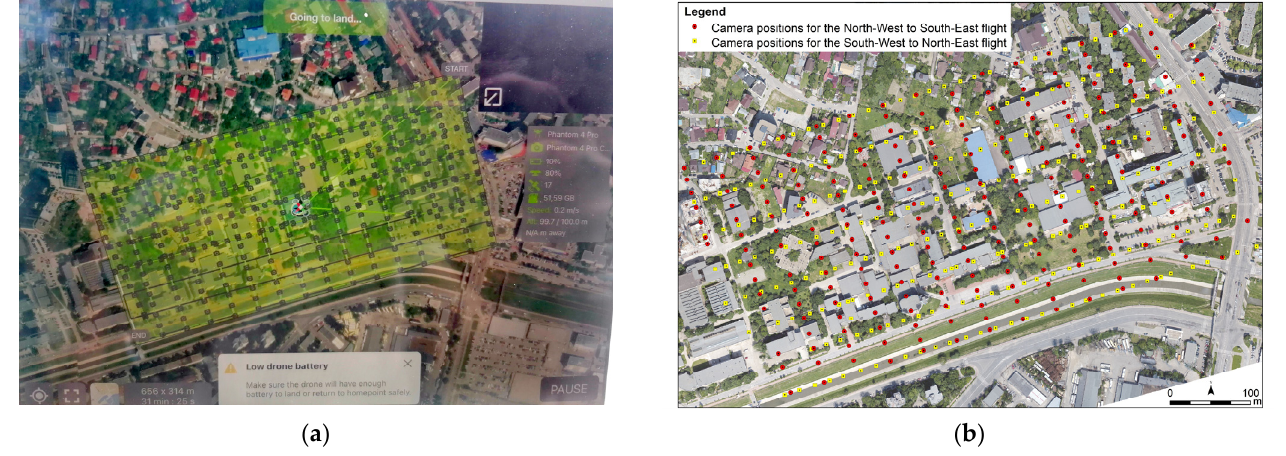
Figure 6. ( a ) UAS image acquisition in automatic manner with “Pix4D Capture” software, ( b ) Camera positions for the North-West to South-East flight (red) and for the South-West to North-East flight (yellow) on the Unmanned Aerial Systems (UAS)-derived orthophoto. During the flight, the 20 artificial GCPs have been marked with plates made by orange plexiglass and two black triangles, 3 mm thickness, 40 cm × 40 cm dimension, with a hole in the center of 5 mm diameter.